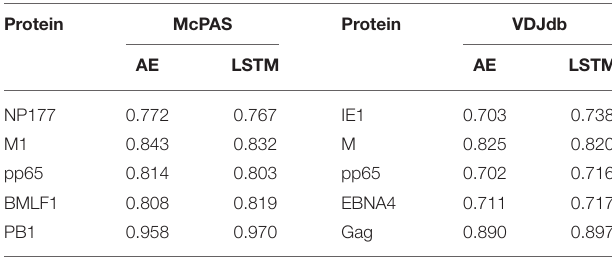
TABLE 3 | Comparison between the different versions of the ERGO classifier [AE vs. LSTM and McPAS (23) vs. VDJdb (27)] for the binding to a specific antigen. Protein McPAS Protein